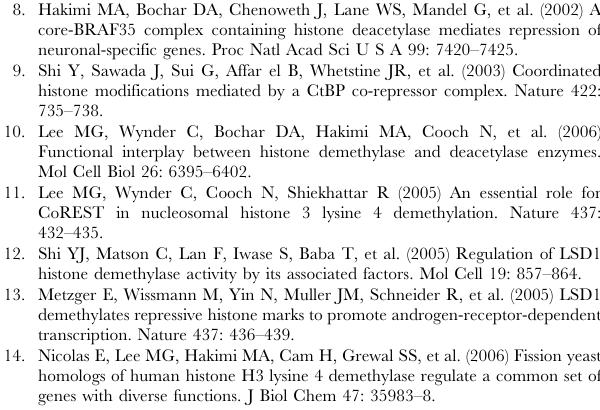
Table S3 Genes that have either increased levels of